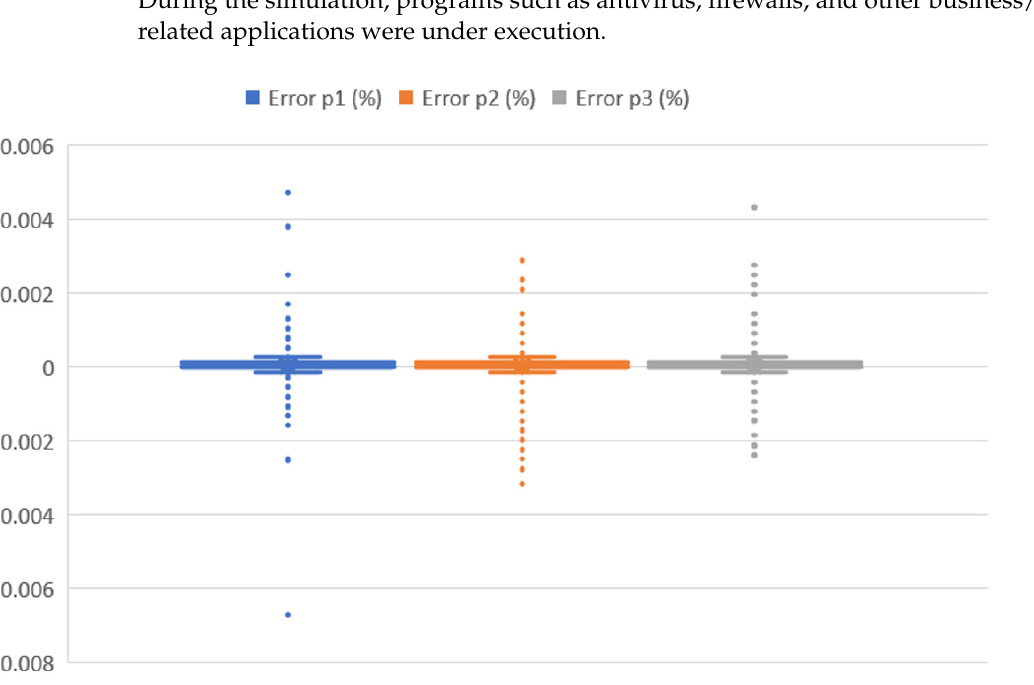
Table 3. Partition statistics for Circuit 5 feeder, four zones.